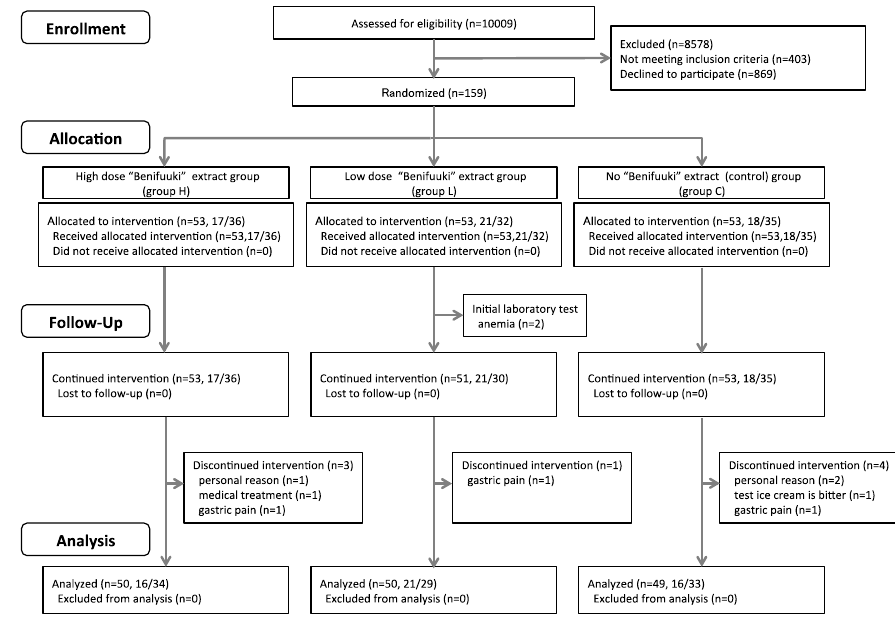
Figure 2. Flowchart of the study.